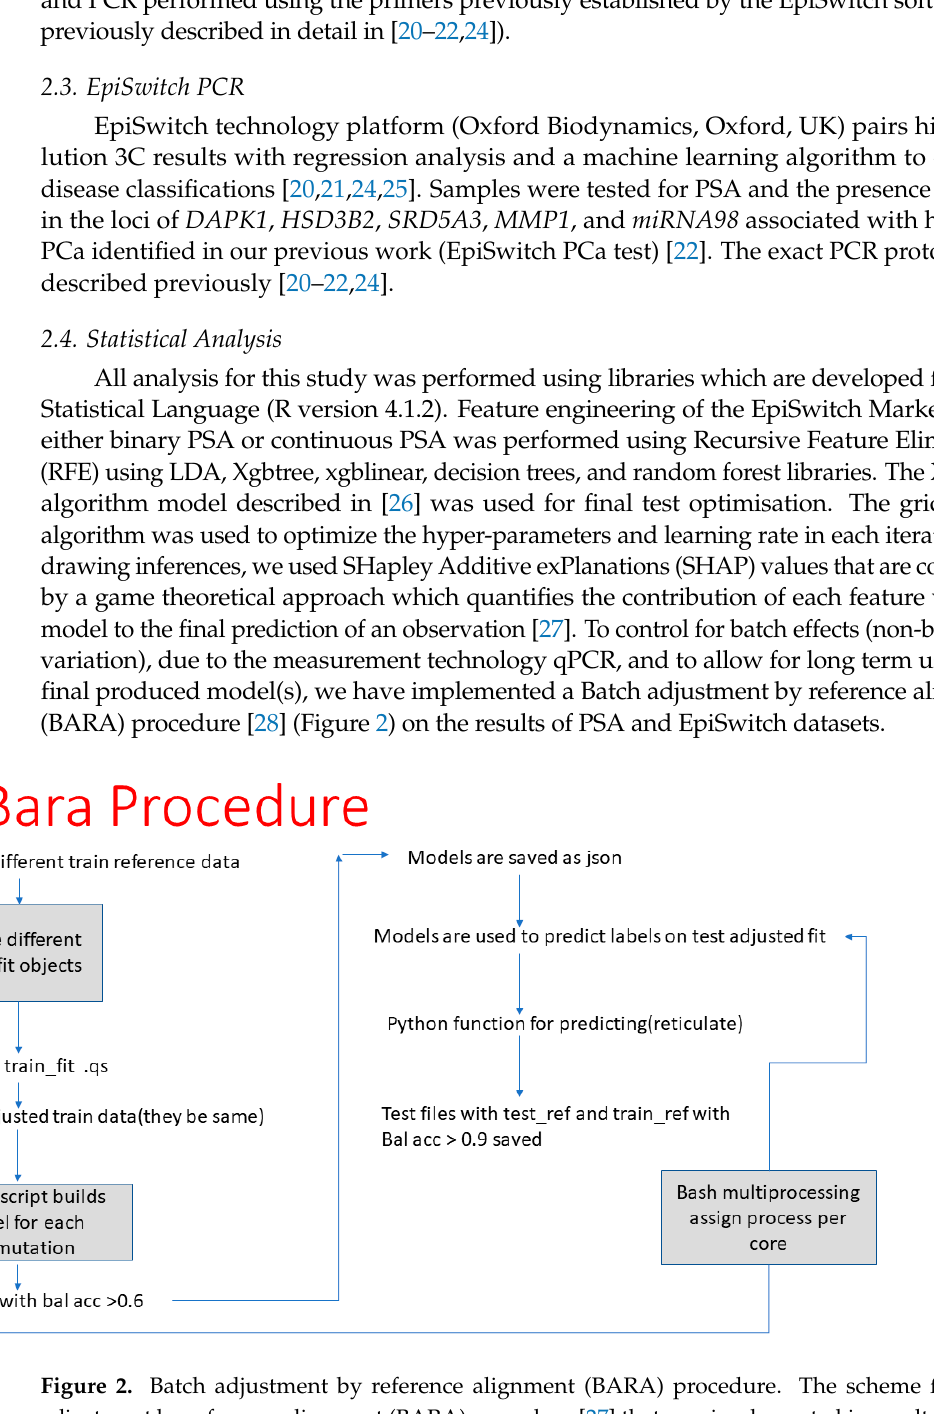
Figure 2. Batch adjustment by reference alignment (BARA) procedure. The scheme for batch adjustment by reference alignment (BARA) procedure [27] that was implemented in results analysis for better control of batch effects (non-biological variation).